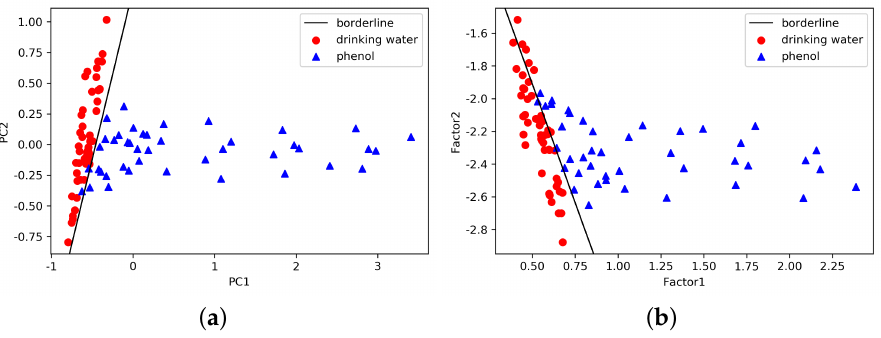
Figure 8. Distinction of low-concentration training samples after dimension reduction